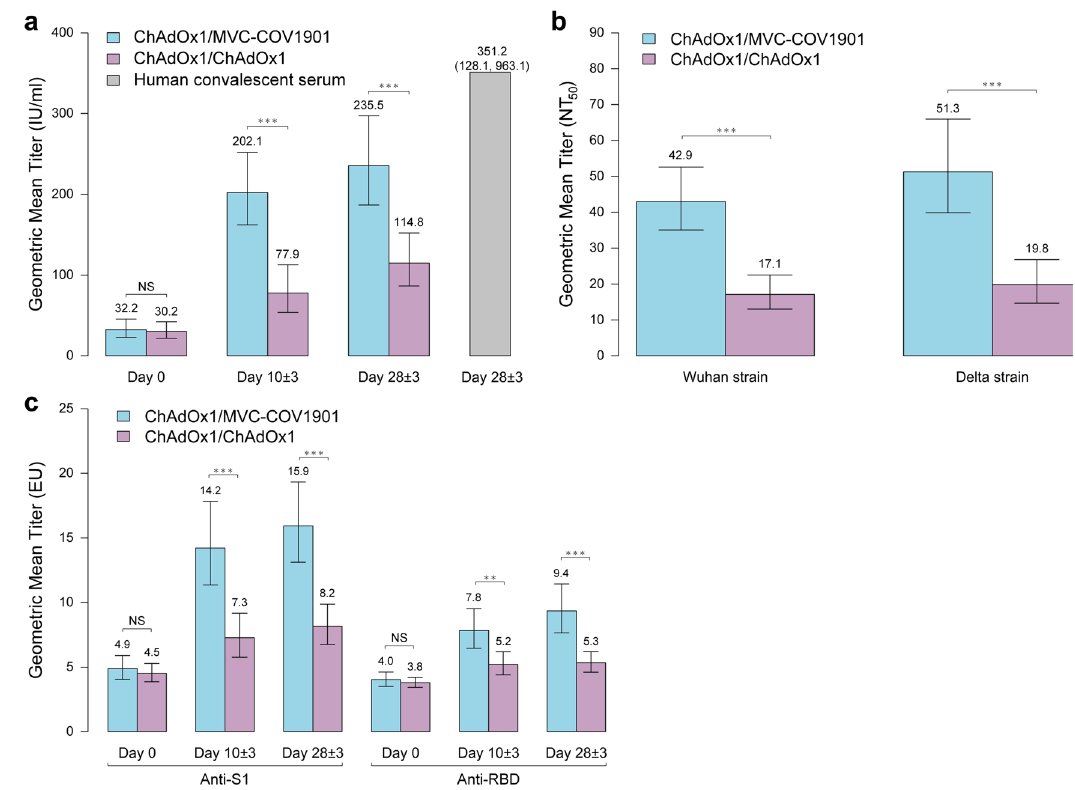
Fig. 3 | Comparison of antibody titers between heterologous ChAdOx1/MVC- COV1901( n =50) and homologous ChAdOx1/ChAdOx1 ( n =50)groupspriorto and after booster vaccination. a Neutralizing antibody titers measured by ELISA- based method. The data from 15 human convalescent serum samples collected at day 28±3 after diagnosis is shown for comparison (grey bar). The values in inter- national units per milliliter (IU/mL) are provided. Data are presented as geometric mean ±95% con fi dence intervals. The signi fi cance between two groups was deter- mined using t test (two-tailed). Comparisons of antibody titers, Day 0, P =0.7900; Day10±3, P <0.0010;Day28±3, P <0.0010. b